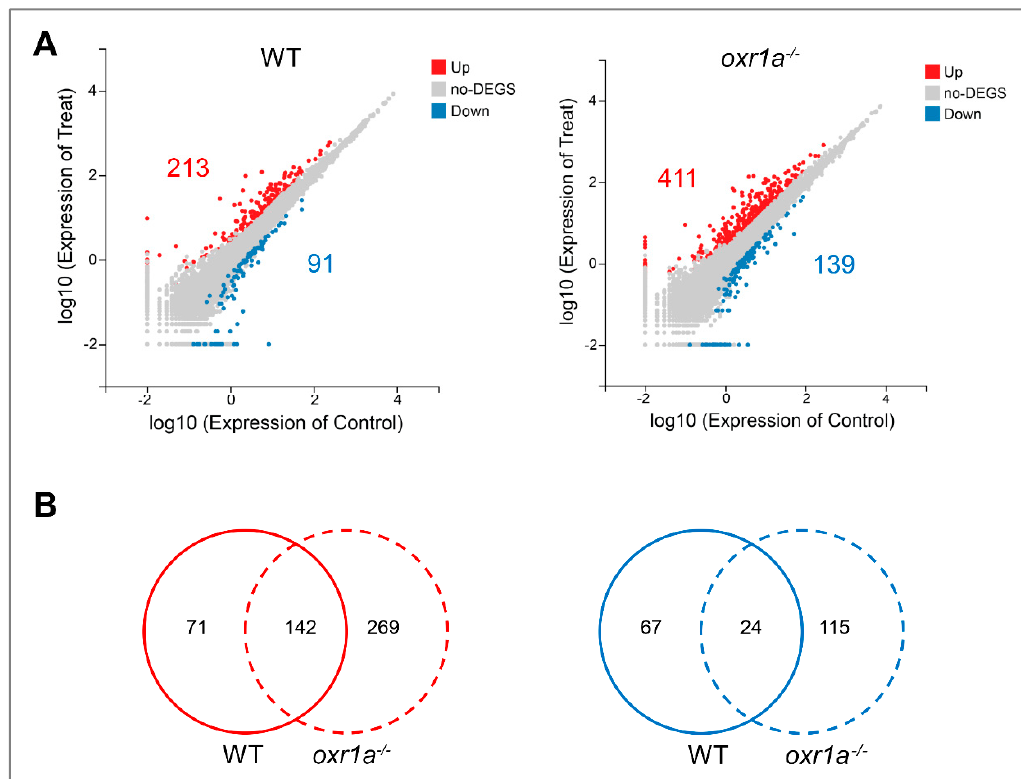
Figure 8. The differential expression analysis in WT and oxr1a − / − mutant zebrafish during oxidative stress. ( A ) Scatter plot of differential expression genes in WT and oxr1a − / − mutant zebrafish under H 2 O 2 stress. The red and blue indicate the number of upregulated and down regulated genes, respectively. ( B ) Venn diagram analysis of commonly or uniquely change for gene expression in WT and oxr1a − / − mutant zebrafish during H 2 O 2 stress.